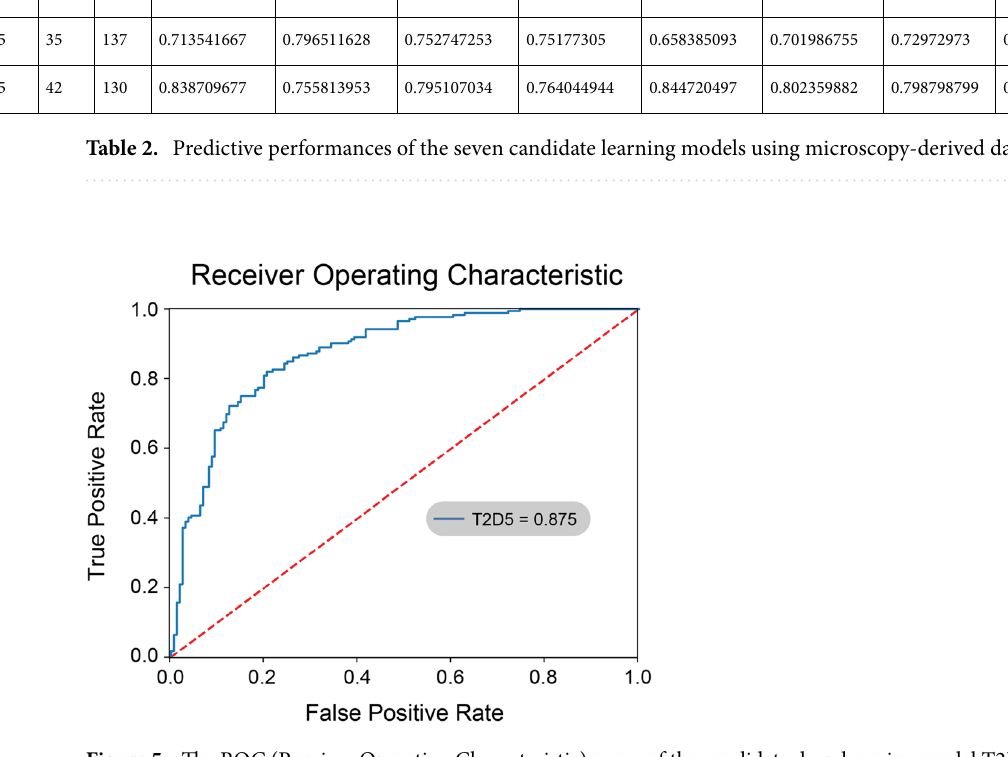
Figure 5. The ROC (Receiver Operating Characteristic) curve of the candidate deep learning model T2D5. The model showed relatively good performance when predicting FCD-HT cells (precision: 0.84, recall: 0.76, accuracy: 0.80, and AUC: